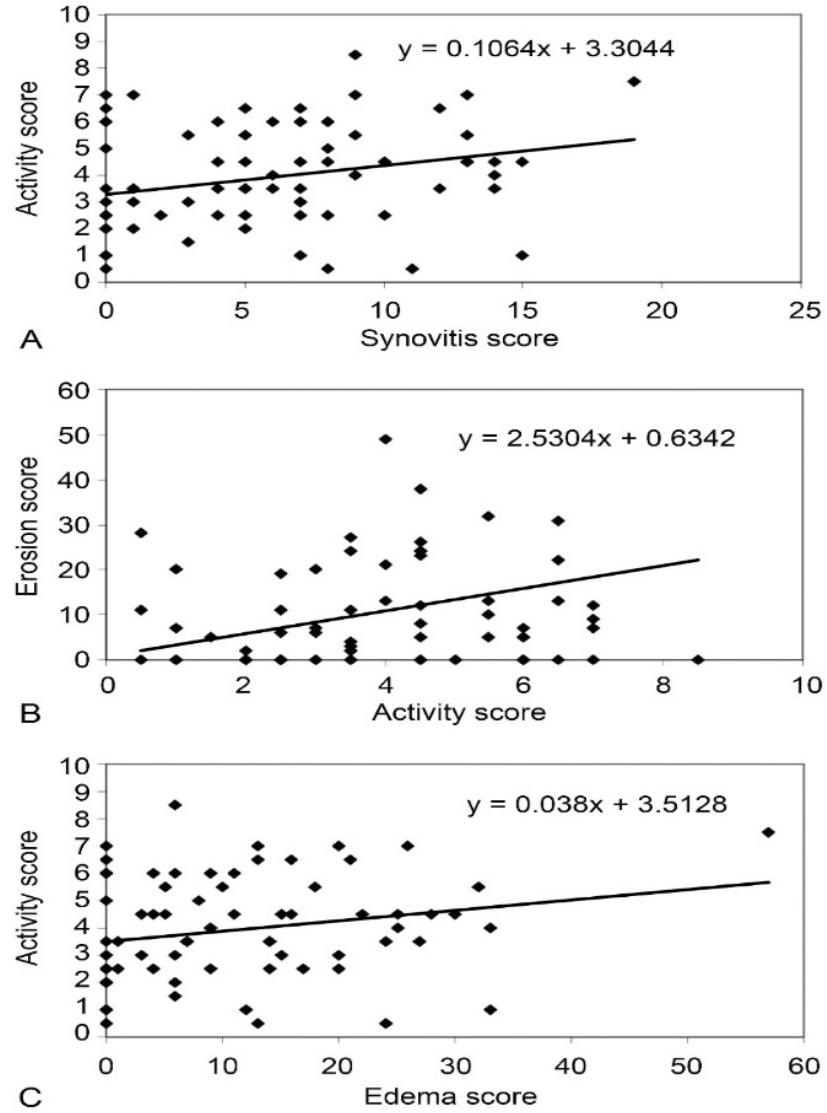
Figure 1. Correlation between synovitis score and EScSG-AI in patients with SSc ( A ), between EScSG-AI and erosion score in SSc group ( B ), and between edema score and EScSG-AI in patients with SSc ( C ). In RA, a significant correlation was confirmed between synovitis score, erosion score (r = 0.698 and p < 0.001), and edema (r = 0.622 and p < 0.001) on MRI and disease activity score, DAS 28SE (r = 0.344 and p <